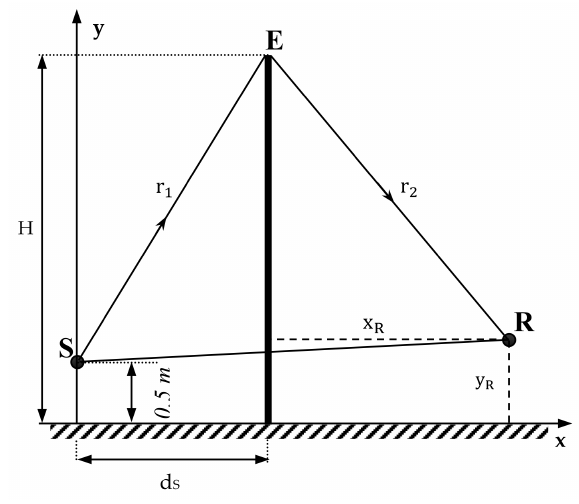
Figure 1. Diffraction of sound by a thin